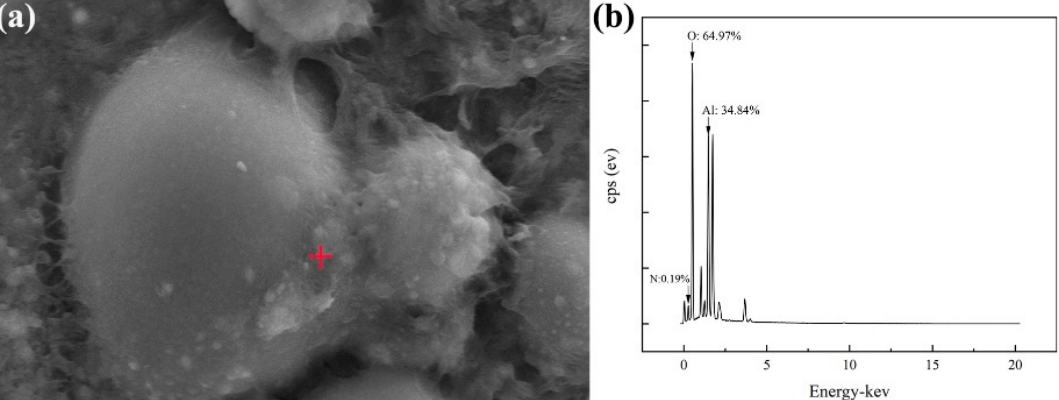
Figure 17. EDS analysis of daughter Al-Li alloy residues. ( a ) SEM morphology; ( b ) EDS spectrum.